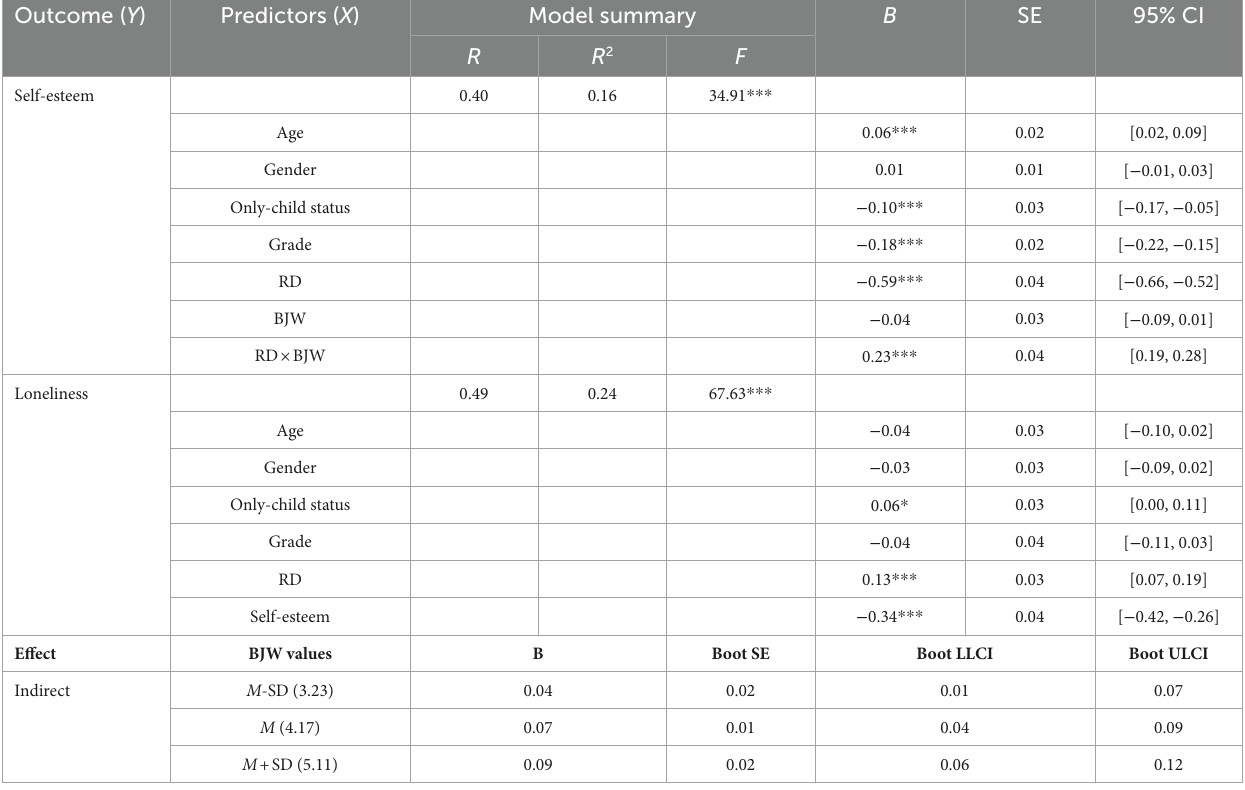
TABLE 4 Moderated mediation analysis results with belief in a just world as a moderator.